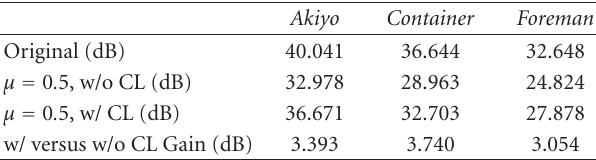
Table 1: PSNR values (in dB) for the subjective quality